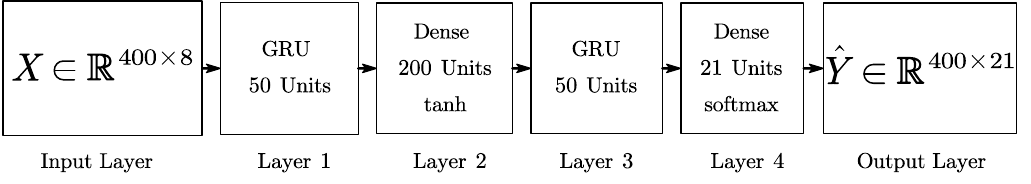
Figure 5. The model structure of recurrent neural network (RNN).